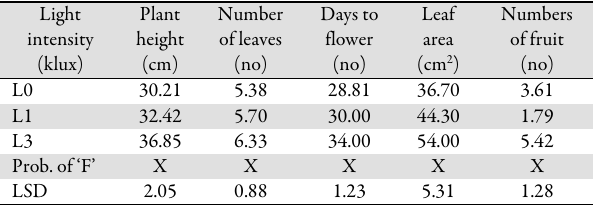
Table 9. Interactive effects of compost application and light intensity on the vegetative growth of okra on the field Light